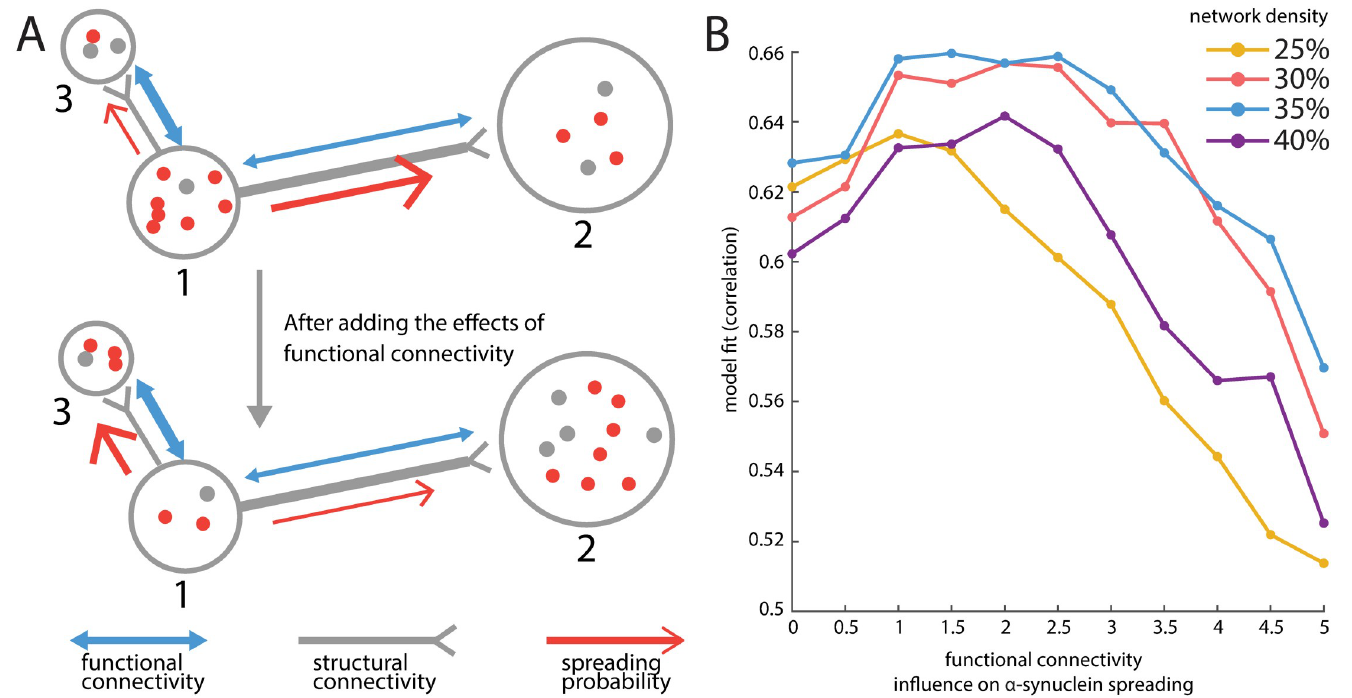
Fig 7. Incorporating functional connectivity improves model fit. (A) An illustration of incorporating the influence of functional connectivity. Region 1 is more densely connected with region 2 than with region 3 (i.e., structural connectivity w 12 > w 13 ) but coactivates more with region 3 than with region 2 (i.e., functional connectivity fc 12 > fc 13 ). If functional connectivity is not incorporated, the probability of spreading toward region 2 or 3 for agents in region 1 is proportional to the structural connectivity w 12 or w 13 (upper panel); after functional connectivity is incorporated, these probabilities are rescaled to be proportional to exp ( k × fc 12 ) w 12 and exp ( k × fc 13 ) w 13 , respectively (lower panel), in which k is a factor to control the importance of functional connectivity. (B) Resting-state fMRI functional connectivity was incorporated in the model by tuning the probability of α -synuclein propagation along structural connections. As the influence of functional connectivity is increased, α -synuclein spreading is biased towards structural connections that exhibit high functional connectivity. Model fit is shown for a range of structural connection densities. A balanced effect of functional connectivity and structural connectivity improves model performance, while excessive influence of functional connectivity degrades model fit. The same beneficial effect is not observed when randomized “null” functional connectivity patterns are used (S7 Fig). The underlying data can be found at